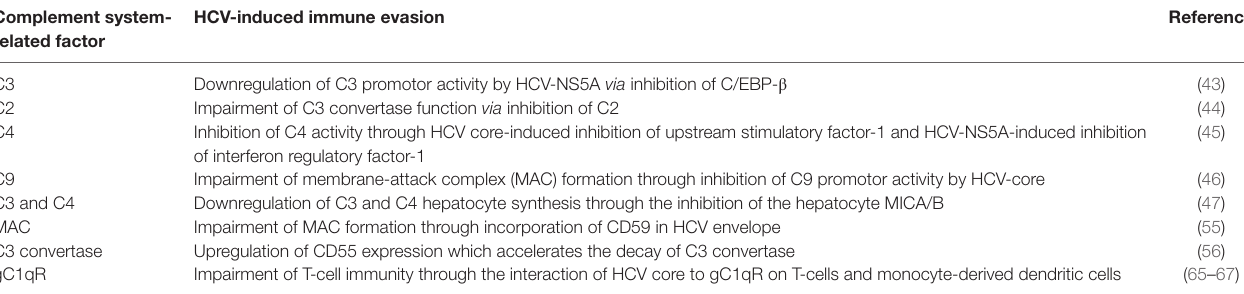
TABLe 2 | HCV strategies to evade innate and adaptive immunity using complement system-related components. Complement system- related factor